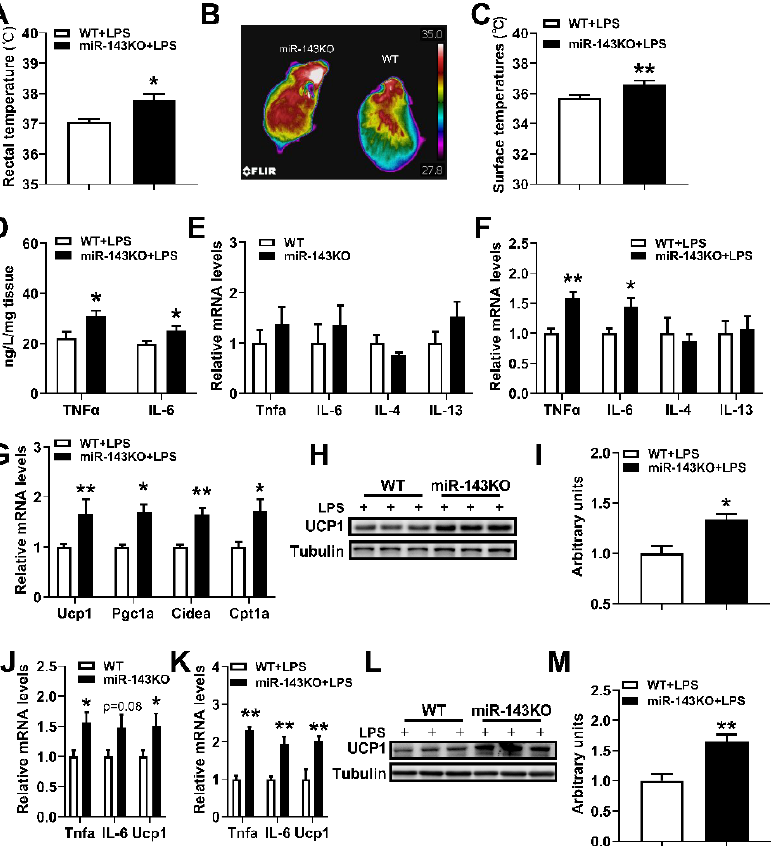
Figure 5. miR-143KO promotes LPS induced thermogenesis in the BAT. ( A ) Rectal temperatures of WT and miR-143KO mice treated with 10 µ g/kg LPS for 1.5 h. ( B , C ) Dorsal interscapular surface imaging and temperature. ( D ) The concentrations of TNF α and IL-6 in the BAT of mice treated with 10 µ g/kg LPS for 4 h (n = 6). ( E ) The inflammation-related mRNA expression levels in the BAT of WT and miR-143KO mice (n = 8). ( F , G ) The inflammation-related ( E ) and thermogenic-related ( F ) mRNA expression levels in the BAT of WT and miR-143KO mice treated with 10 µ g/kg LPS for 4 h (n = 6). ( H , I ) The UCP1 protein levels in the BAT. ( J ) The mRNA expression levels of TNF- α , IL-6 and UCP1 in the WT and miR-143KO primary brown adipocytes (n = 6). ( K – M ) The TNF α , IL-6 , Ucp1 mRNAs ( J ), and Ucp1 protein ( K , L ) expression levels in WT or miR-143KO primary brown adipocytes treated with 0.2 µ g/mL LPS. Data are presented as the mean ± SEM. * p < 0.05 vs. controls; ** p < 0.01 vs. controls, as determined by Two-tailed unpaired Student’s t